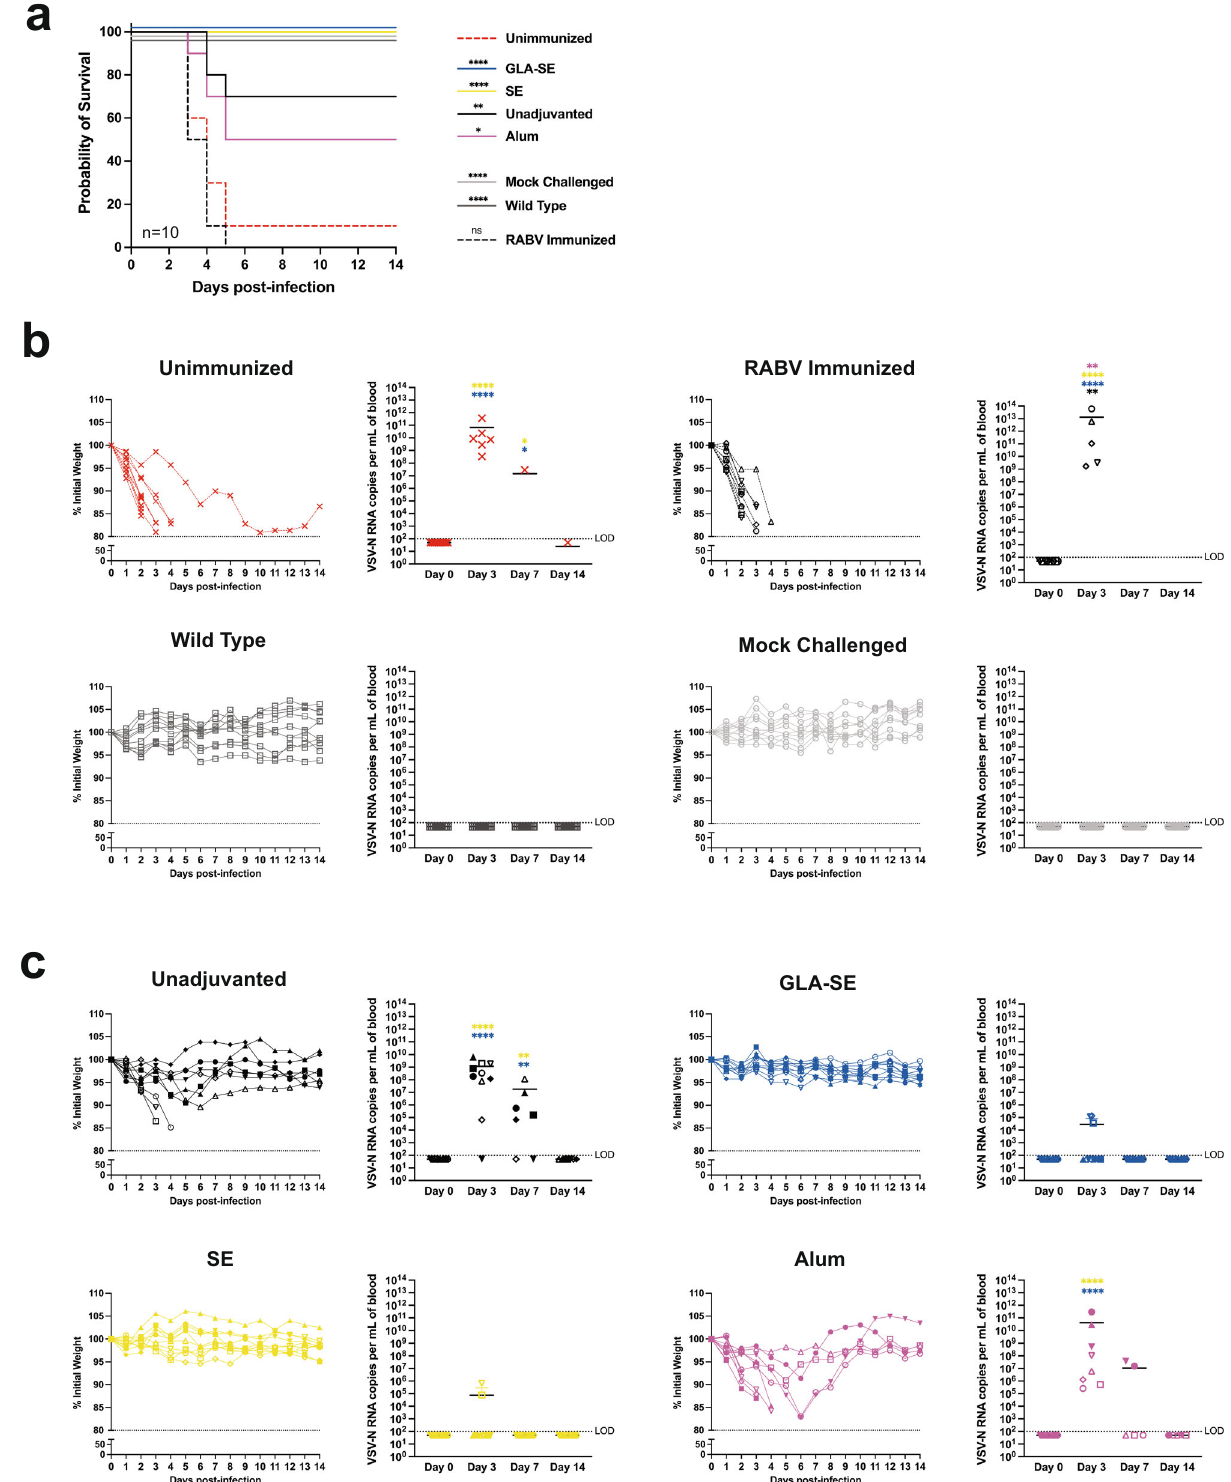
Fig. 4 FILORAB1 immunization adjuvanted with GLA-SE or SE provides total protection from surrogate challenge. a Survival of IFNAR − / − mice challenged intraperitoneally (IP) 4 weeks post-immunization with a lethal dose of VSV Δ G-EBOV-GP (5 × 10 5 PFU). b Weight loss and qPCR of VSV-N RNA in experimental control groups including unimmunized, RABV vector immunized, wild type, and mock challenged mice. c Weight loss and qPCR of VSV-N RNA in FILORAB1 and adjuvant formulation immunized mice post-challenge. Limit of detection (LOD) is 100 copies per/mL (dotted line). Statistics are by simple survival Kaplan – Meier analysis and one-way ANOVA with post hoc Tukey ’ s test of log- transformed RNA copy number. p > 0.1234 (ns), p < 0.0332 (*), p < 0.0021 (**), p < 0.0002 (***), p < 0.0001